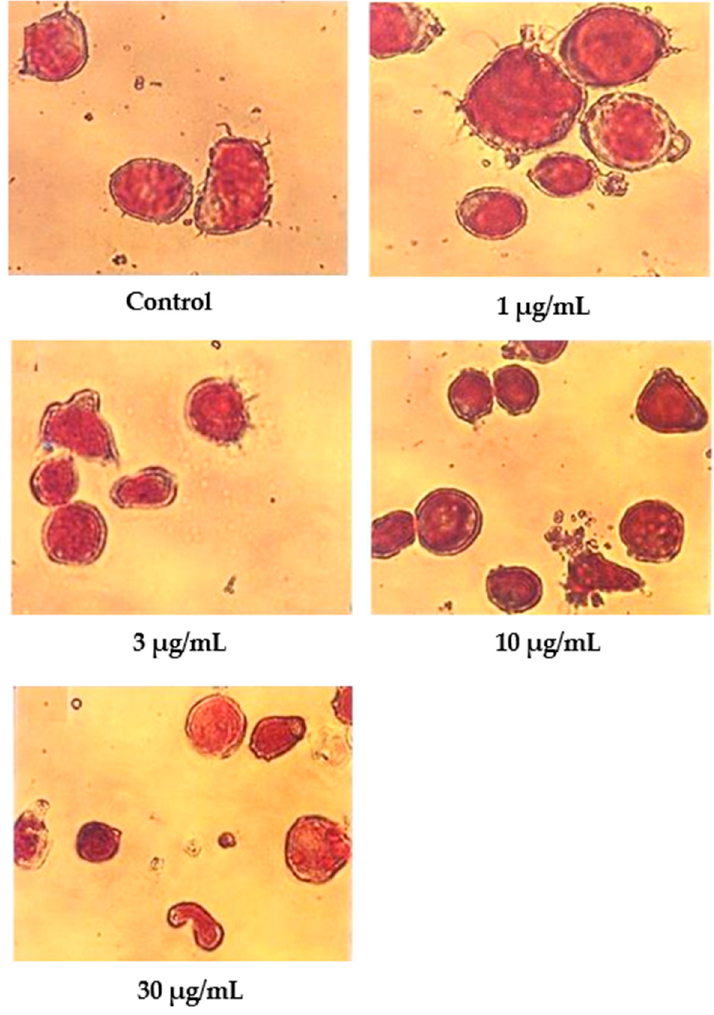
Figure 7. Wright’s-stained CEM-SS cells without treatment (control) or treated with different concentrations of damnacanthal for 24 h (200× magnification).